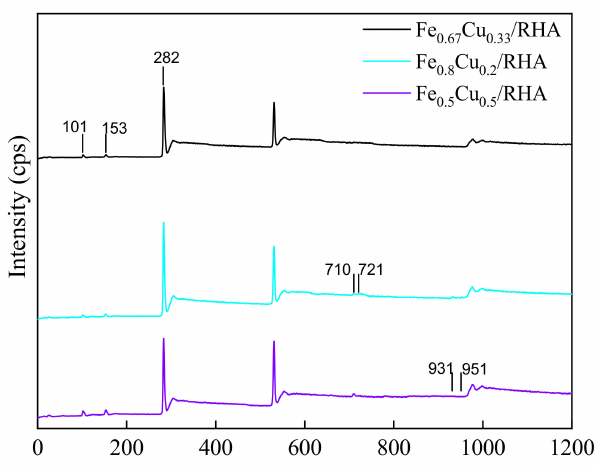
Figure 6. XPS profile of catalysts.